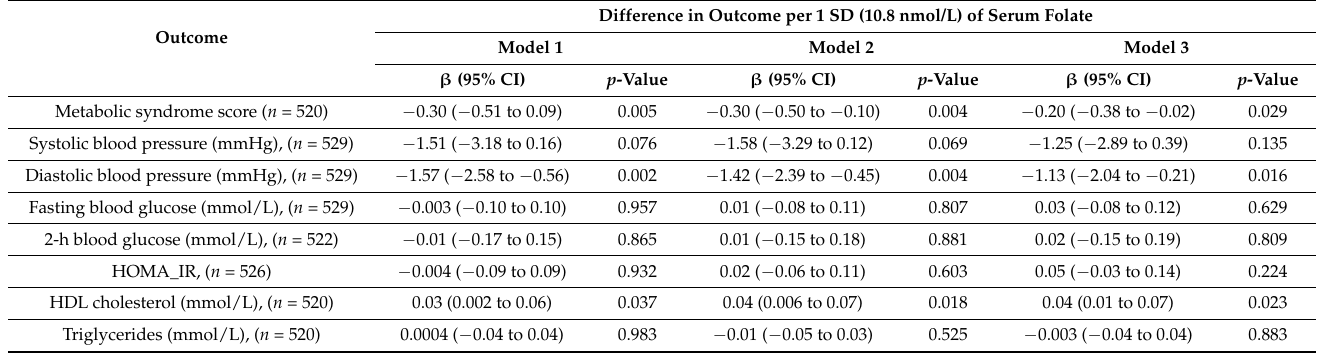
Table 2. Associations between serum folate and metabolic risk factors; Cameroon study.